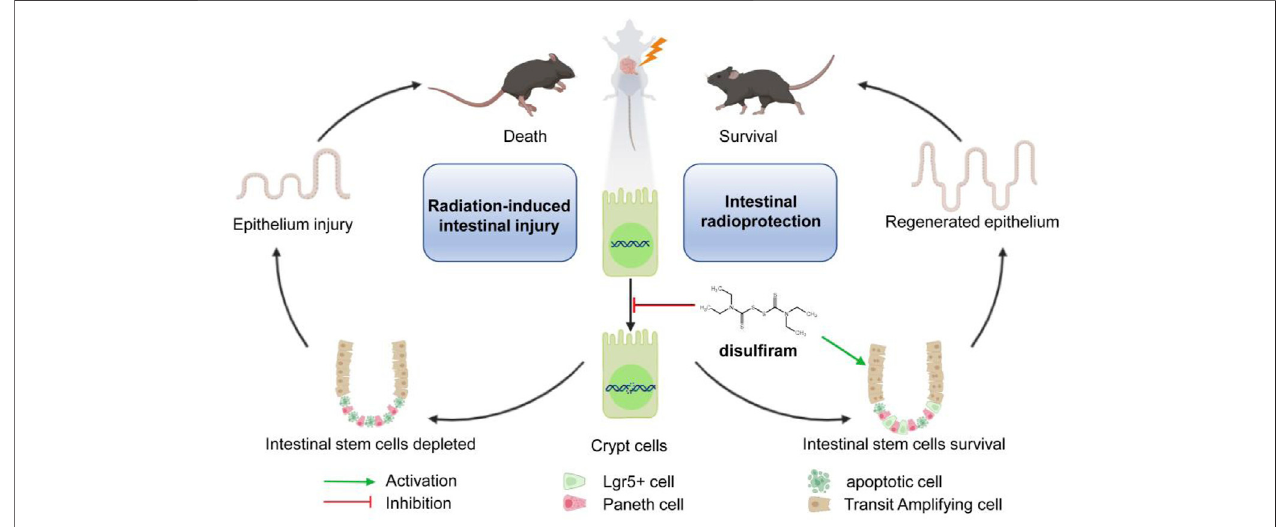
FIGURE 6 | A schematic diagram summarizing the mechanism of Disul fi ram protects against radiation-induced intestinal injury in mice. Ionizing radiation induces cellular DNA double-strand break. DSF reduces the accumulation of DNA lesions and protects intestinal stem cells, which further prevents intestinal injury and improves survival in lethally irradiated